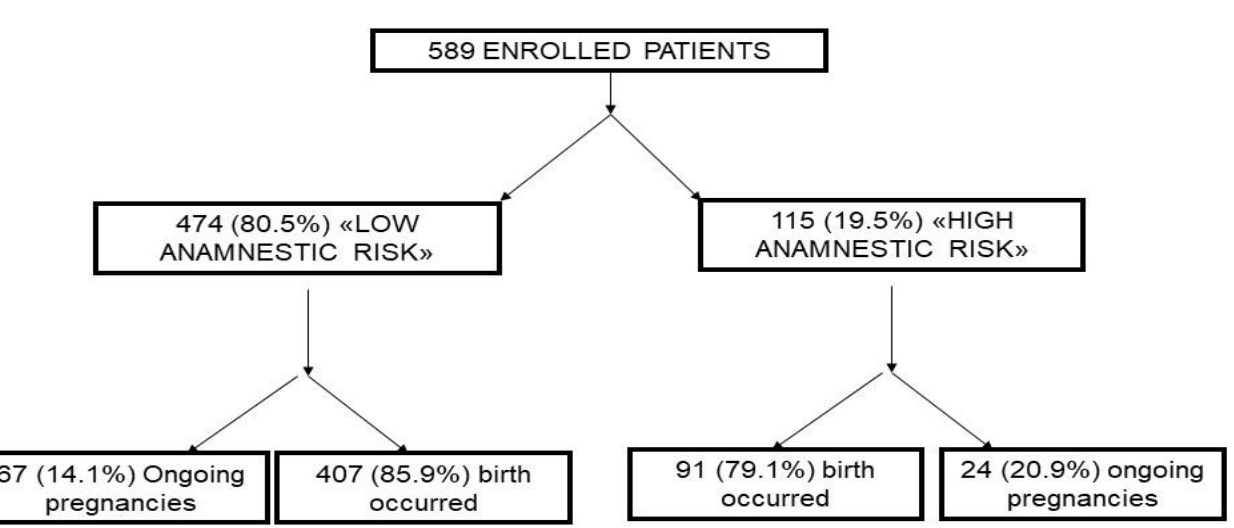
Figure 1. Flow-chart of the study.